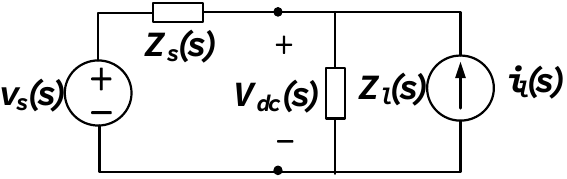
Figure 7. Equivalent model of the VSC – HVDC system.